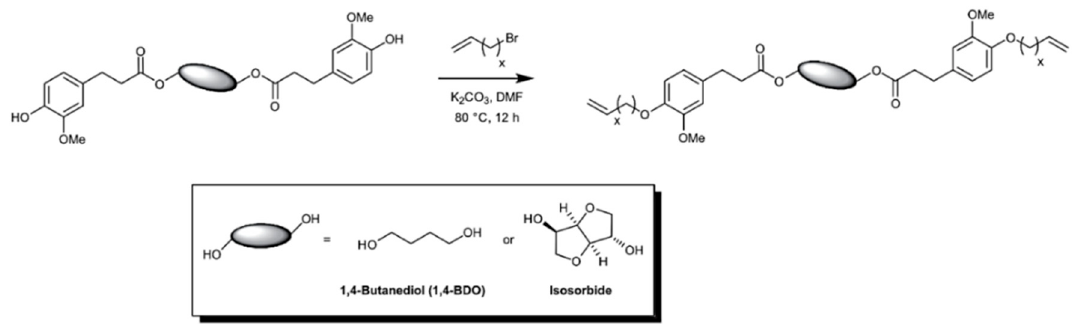
Figure 14. Ferulic acid-derived α , ω -diene monomers. Reproduced with permission [52].